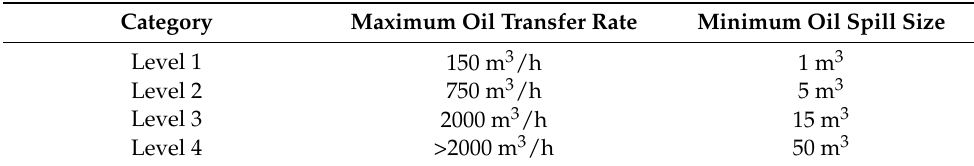
Table 3. Oil Handling Facility